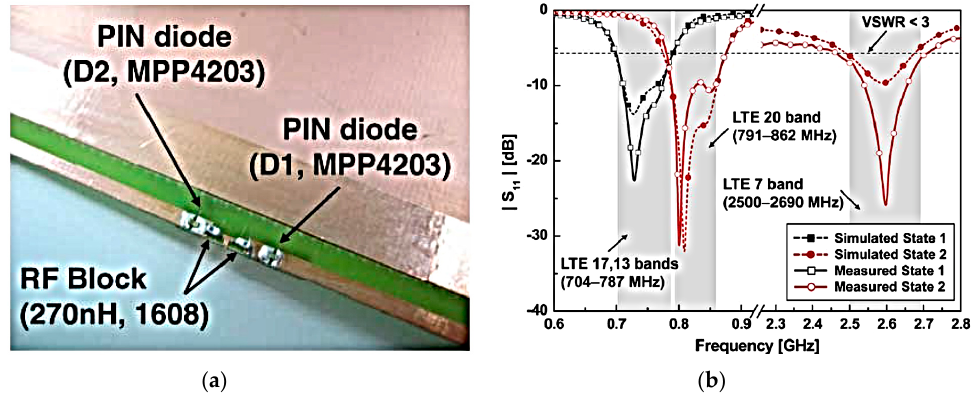
Figure 2. ( a ) Configuration and ( b ) frequency behavior of the reconfigurable antenna (redrawn from [34]).